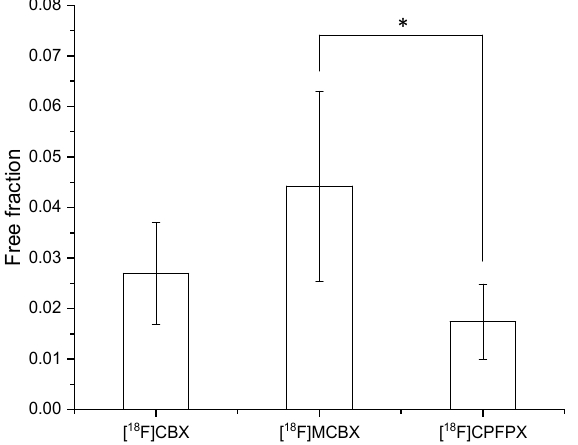
Figure 5. Free fraction of the radiotracers in rat plasma. Data (mean ± SD) were obtained from five ([ 18 F]CPFPX) or seven ([ 18 F]MCBX, [ 18 F]CBX) individual animals. * significantly different ( p < 0.05, one-way ANOVA with post-hoc Tukey test).